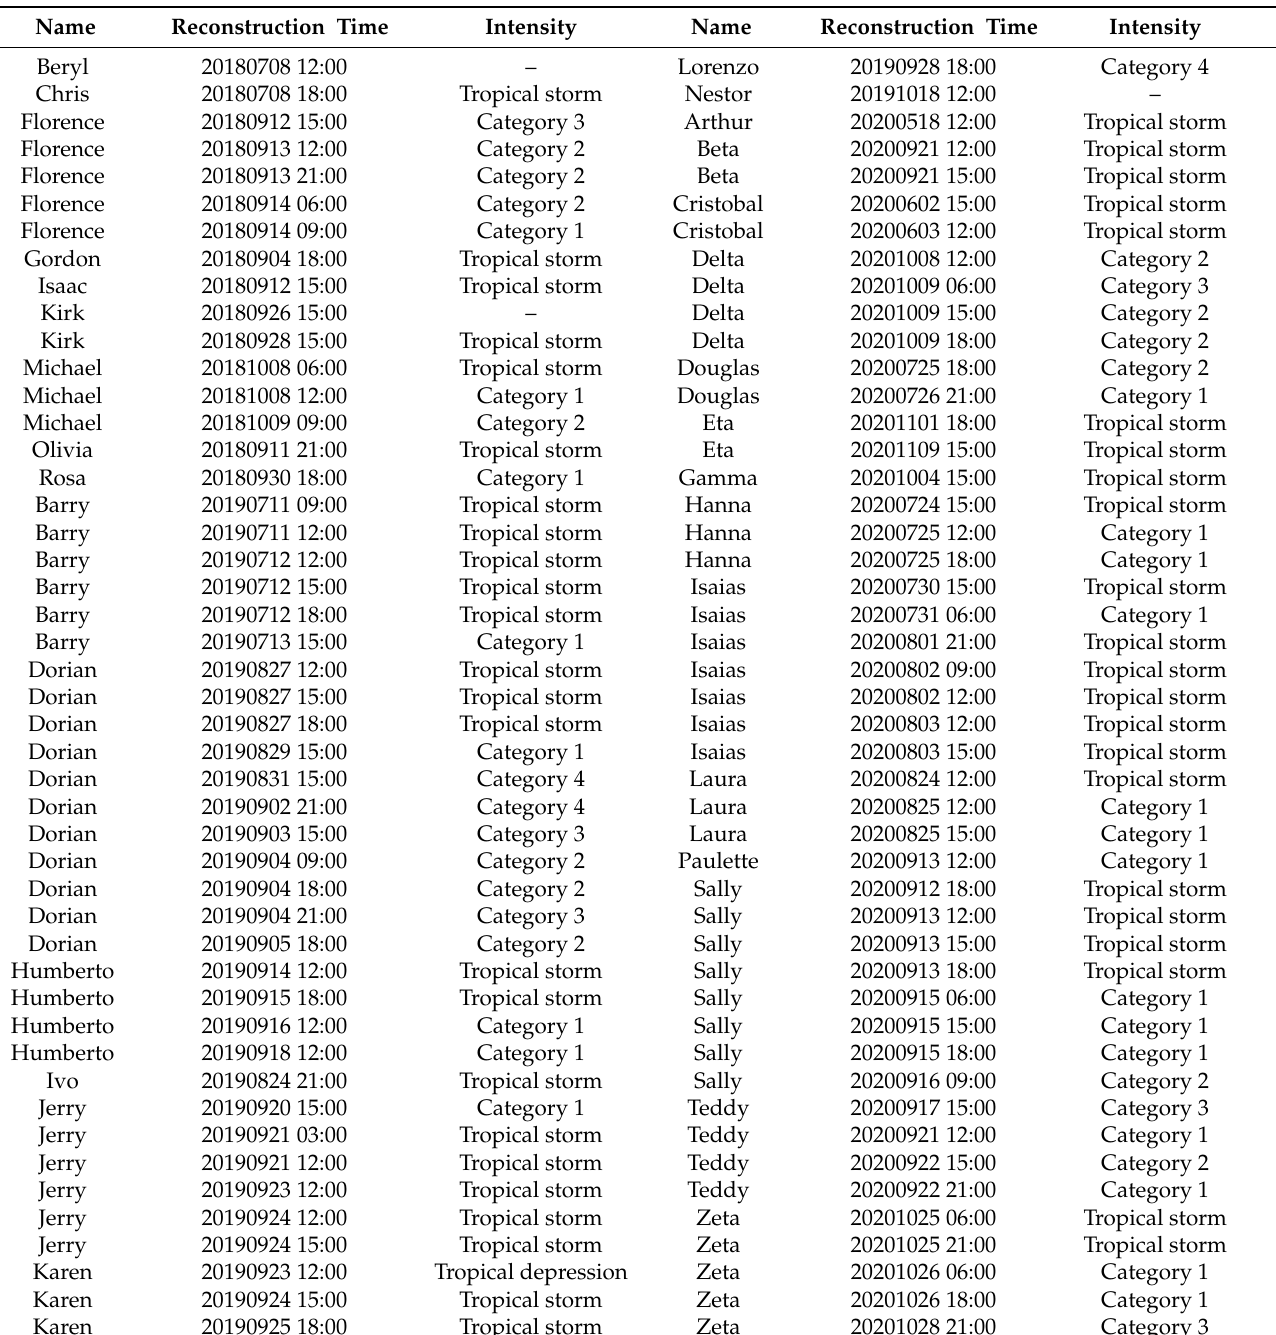
Table 3. Tropical cyclones for the reconstruction and validation during the period